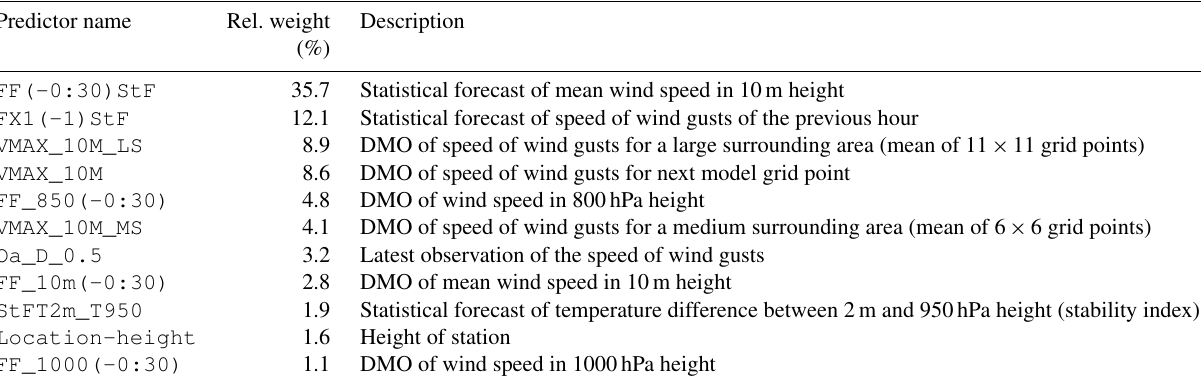
Table 1. Predictors for statistical forecasts of the maximal speed of wind gusts within 1h that have relative weights higher than 1%. The relative weights are aggregated for all stations, seasons, forecast runs, and forecast lead times. The ensemble mean of COSMO-D2-EPS is denoted by DMO (direct model output). Parentheses within the predictor names denote time shifts. For a time shift of − 30min, denoted as ( -0:30 ), the predictors are interpolated based on values for the previous and current forecast hours. The required statistical forecasts have to be evaluated in